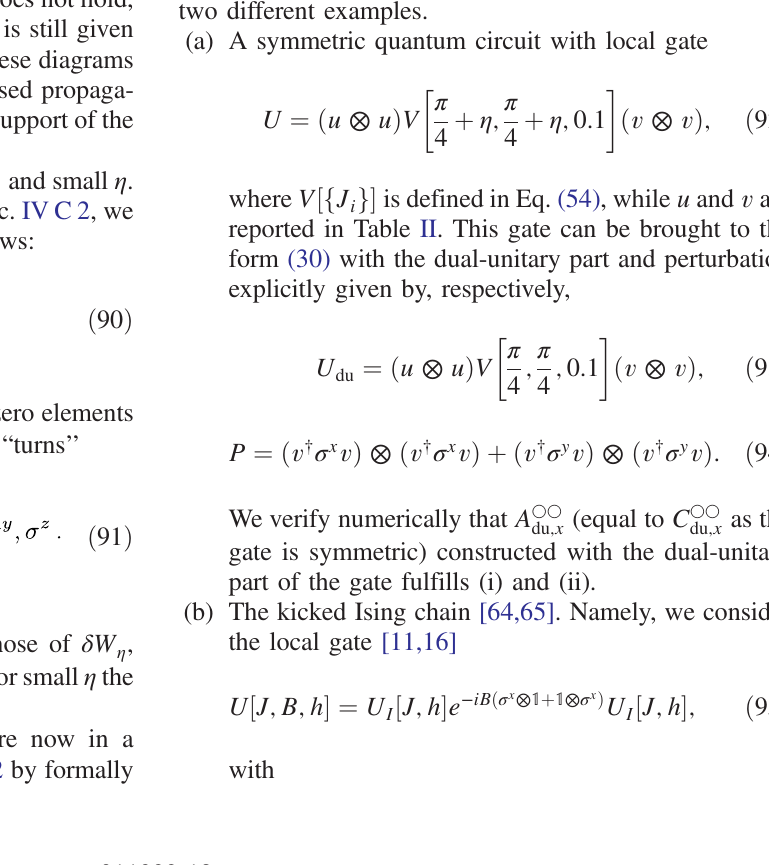
FIG. 7. Left: probability of increase of the first subleading eigenvalue of the transfer matrix A ○○ x − 1 to x . The histogram is generated by considering 1000 matrices (100 for x ¼ 12 , 13) at fixed J 1 ; i ¼ 1 ; 2 ; 3 ; 4 [see the parametrization (53)] and searching for the largest eigenvalues of the transfer matrix up to U(2) matrices u i x ¼ 13 . Right: probability distribution of the transfer matrix ’ s gap Δ ¼ λ 1 − λ 2 , for the 148 cases, which show no increase of the first subleading